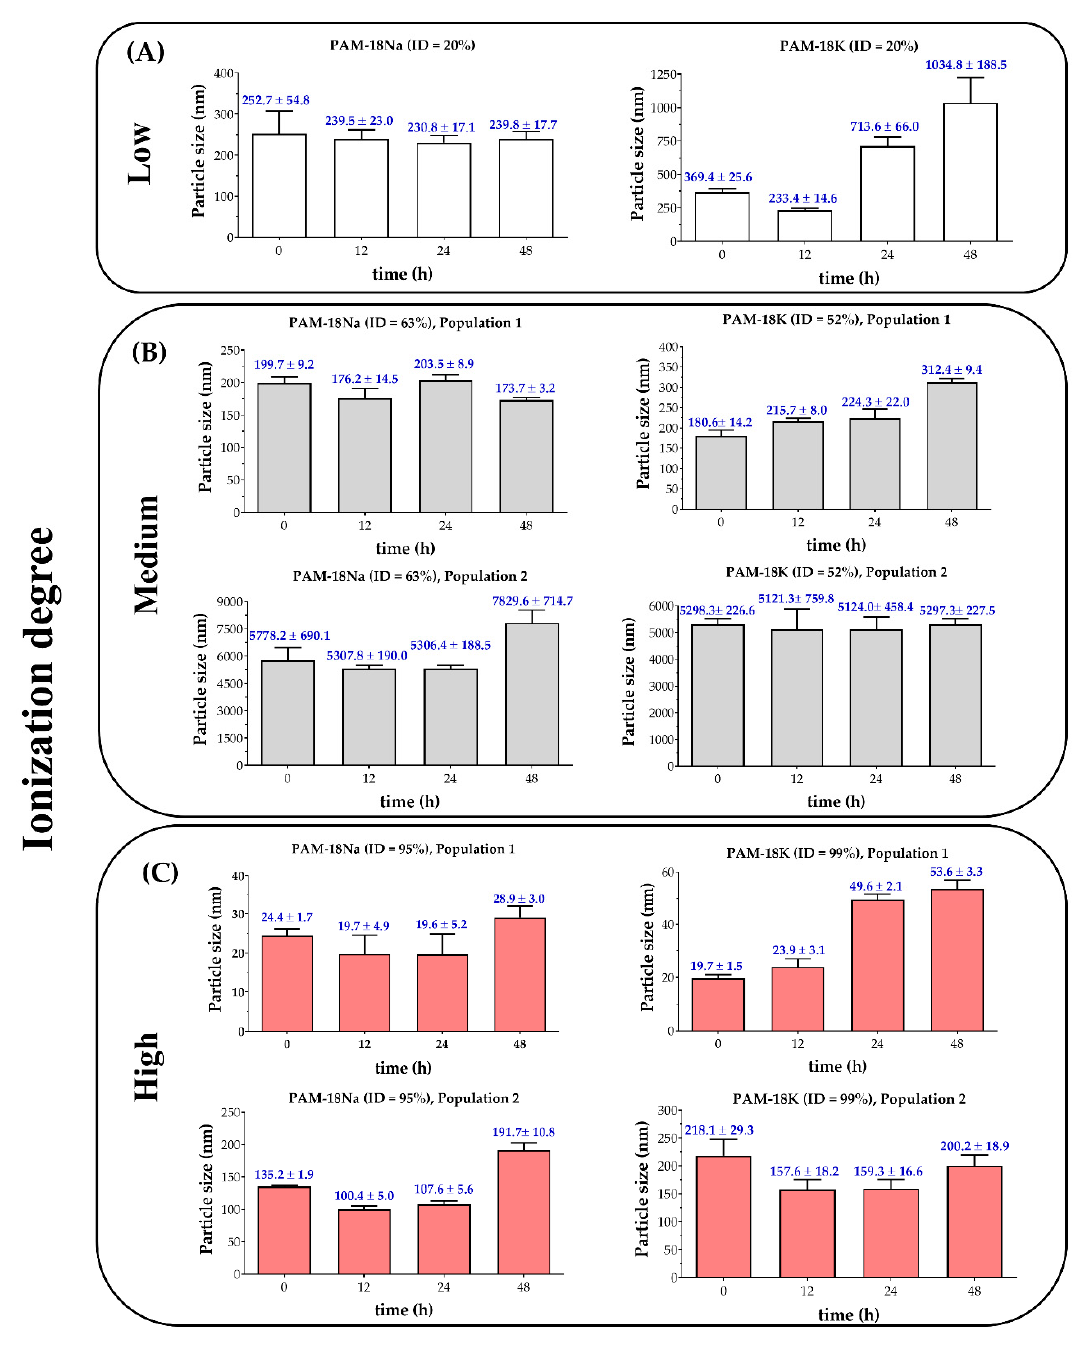
Figure 4. Particle size for PAM-18Na and PAM-18K polyelectrolytes with different ionization degree (ID) in aqueous media. ( A ) Low ionization degree. ( B ) Medium ionization degree. ( C ) High ionization degree.